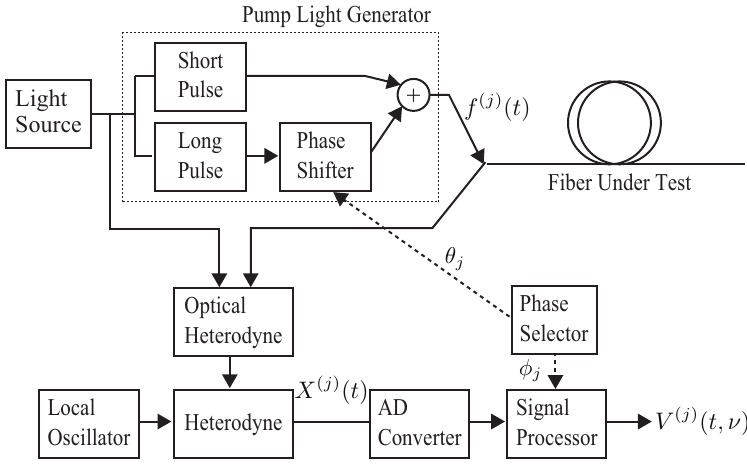
Figure 6. Block diagram of